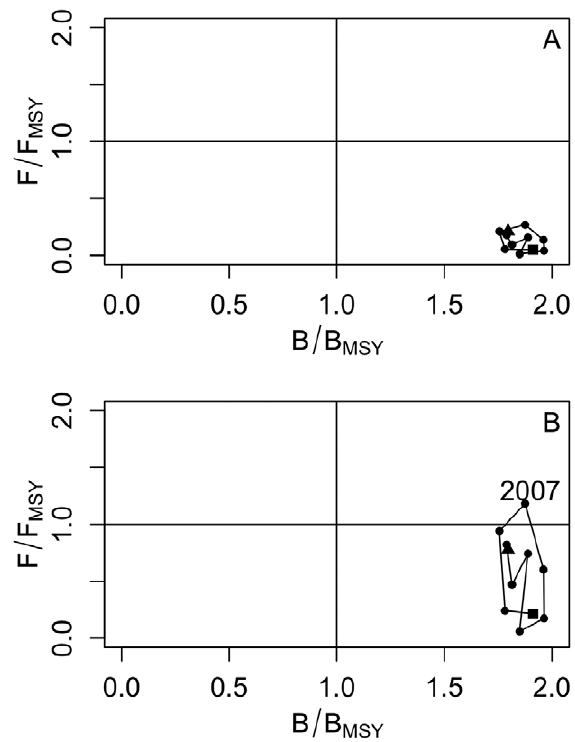
Fig. 7. – Development of the I. argentinus fishery from 2000 to 2010. A, based on the PS model; B, based on the Ps-EDSP model. Triangle represents the biomass status of the first year (2000) of study; square represents the biomass status of the last year (2010).